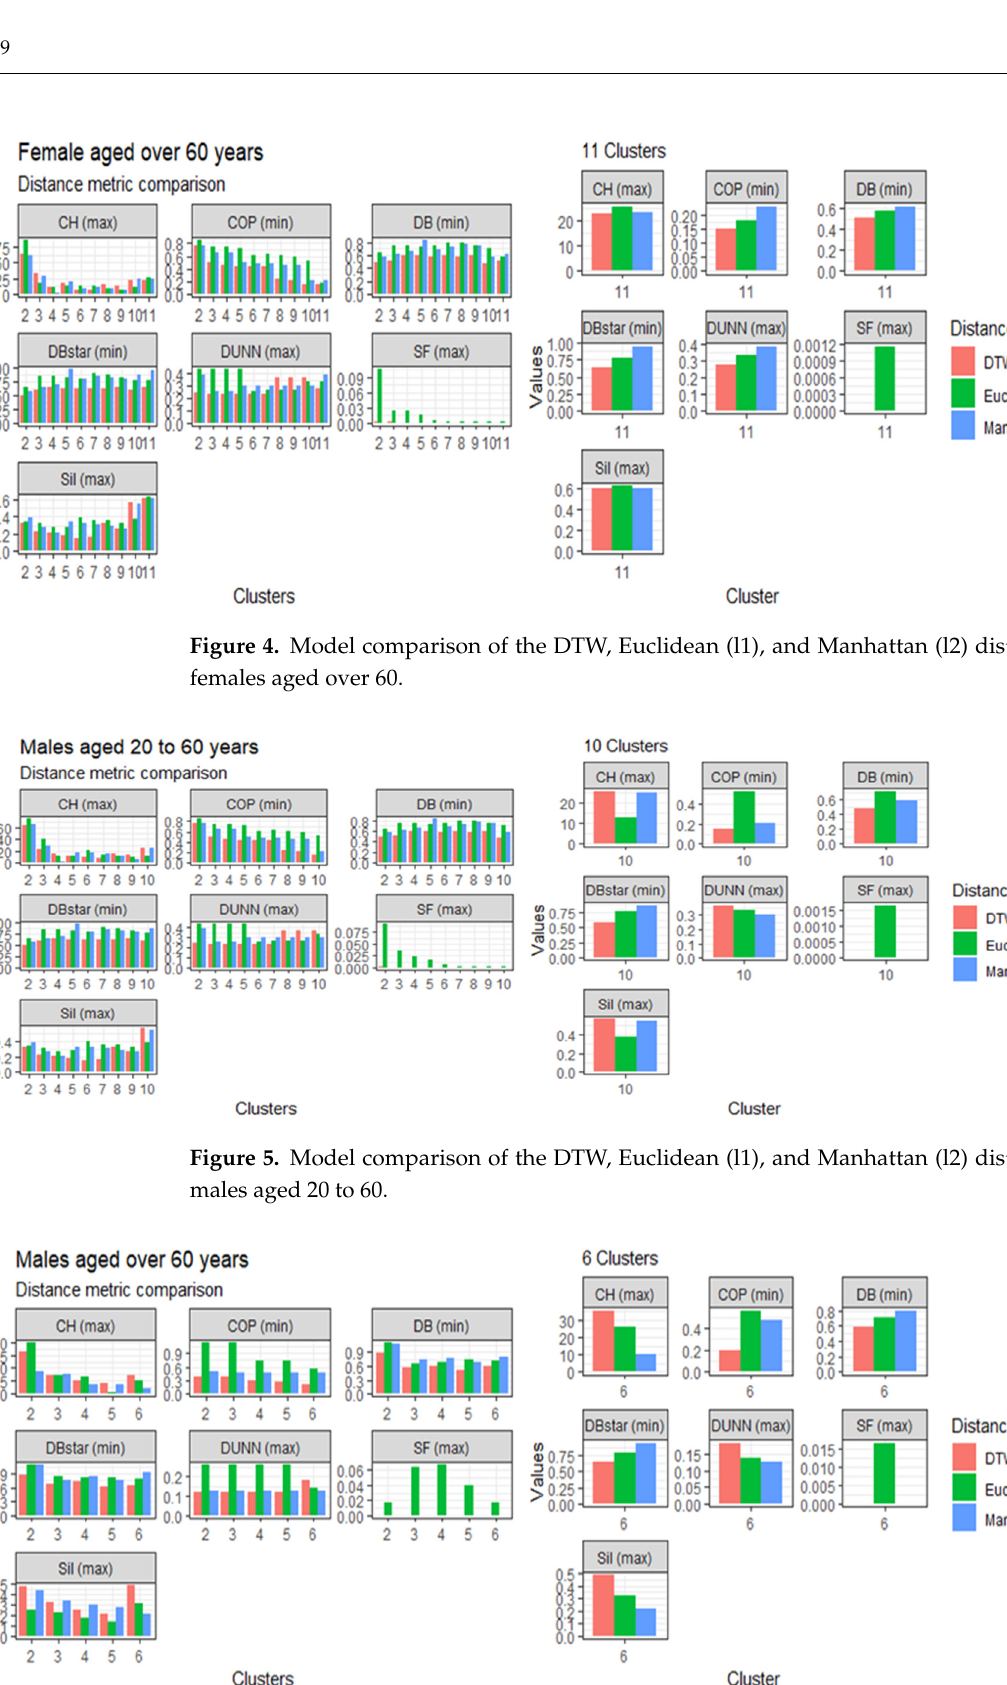
Figure 6. Model comparison of the DTW, Euclidean (l1), and Manhattan (l2) distance criteria for males aged over 60.